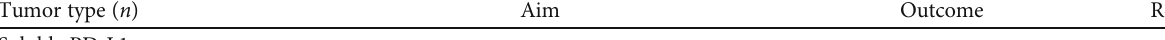
Table 3: Clinical implications of exosomal PD-L1 in cancer diagnosis, prognosis, and immunotherapy response. Tumor type ( n